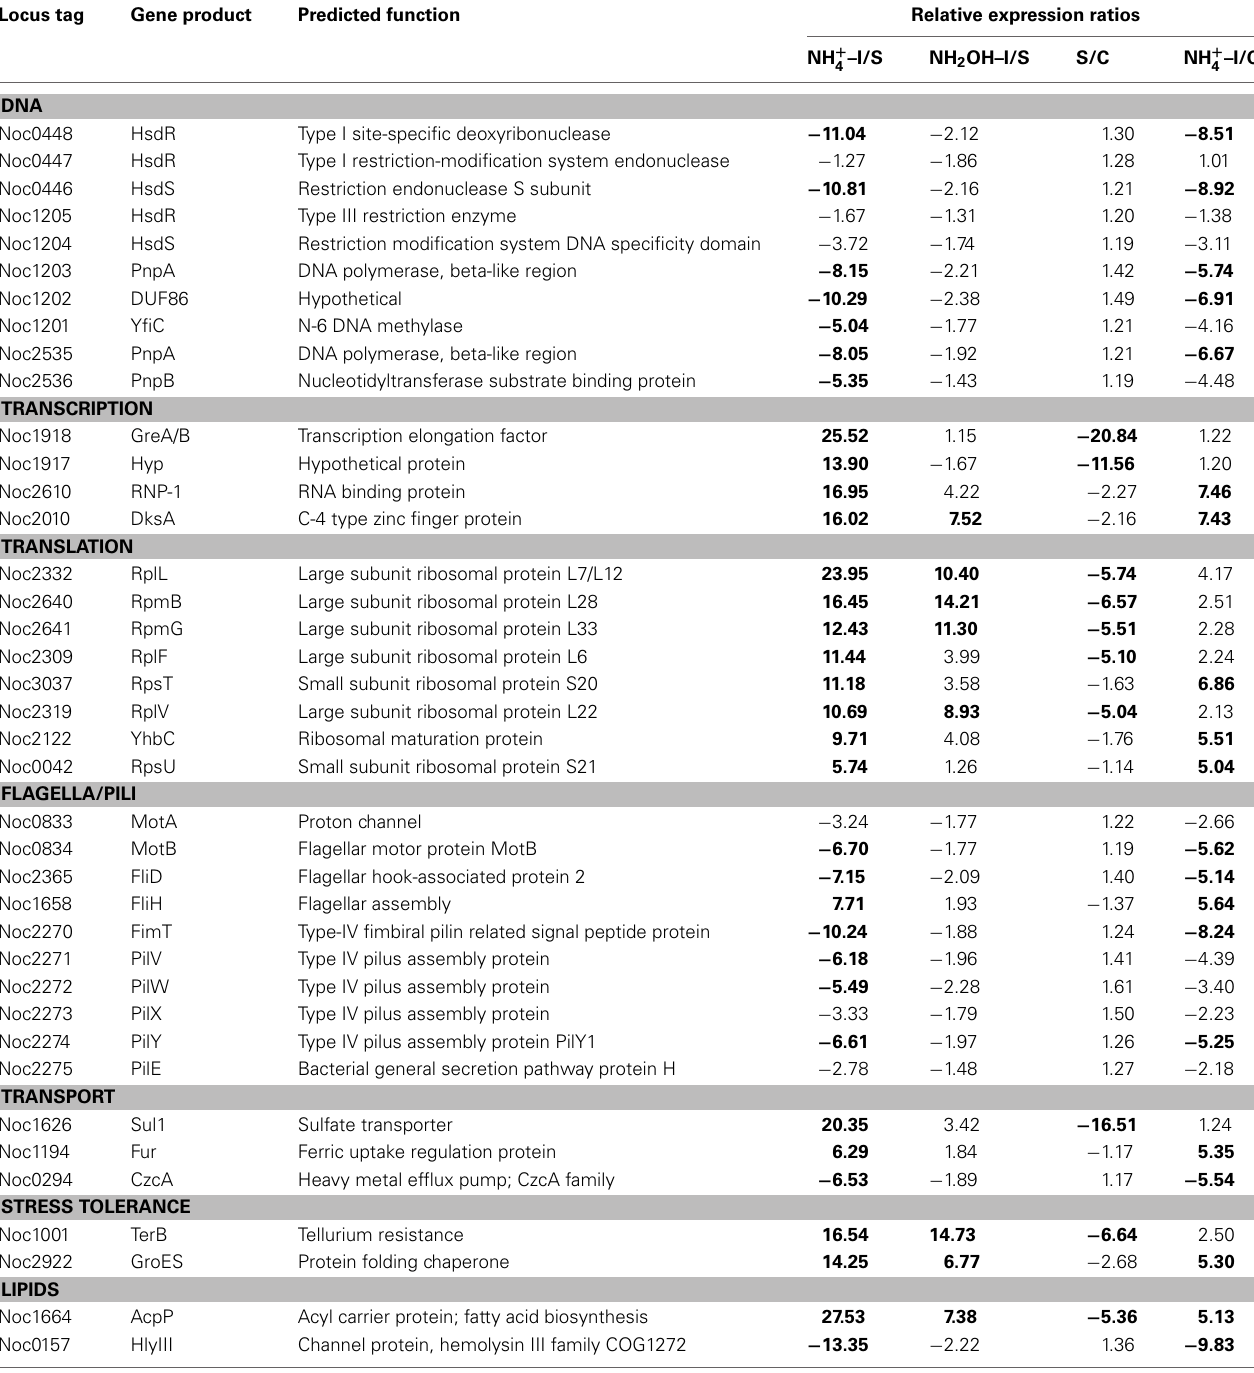
Values represent average ratios from four hybridization experiments per gene, per treatment. Bolded ratios indicate those that are considered to have significant differences in gene expression between compared treatments (changes greater than